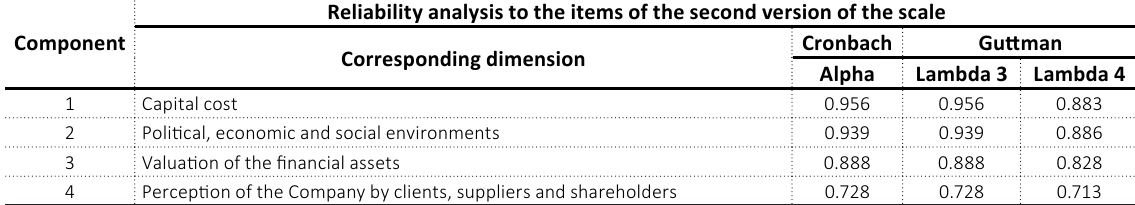
Table 4. Reliability tests for the second instrument Reliability analysis to the items of the second version of the scale Component Corresponding